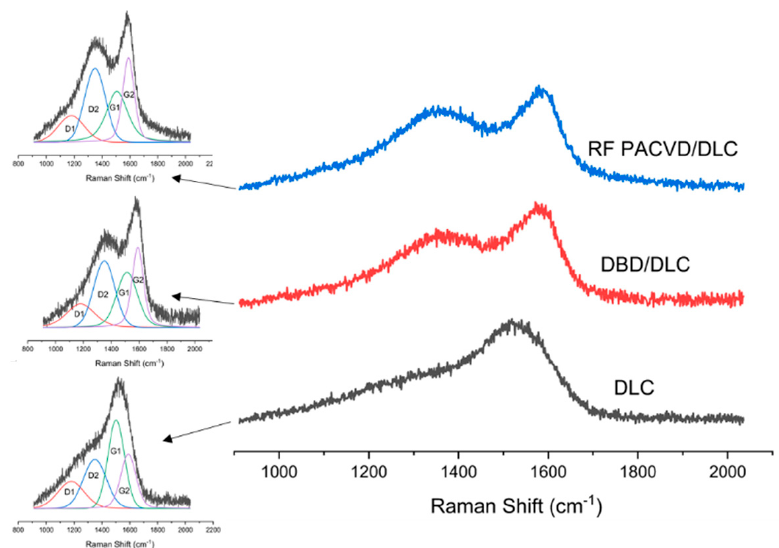
Figure 5. Raman spectra for DLC layers, including their deconvolution into four characteristic peaks.